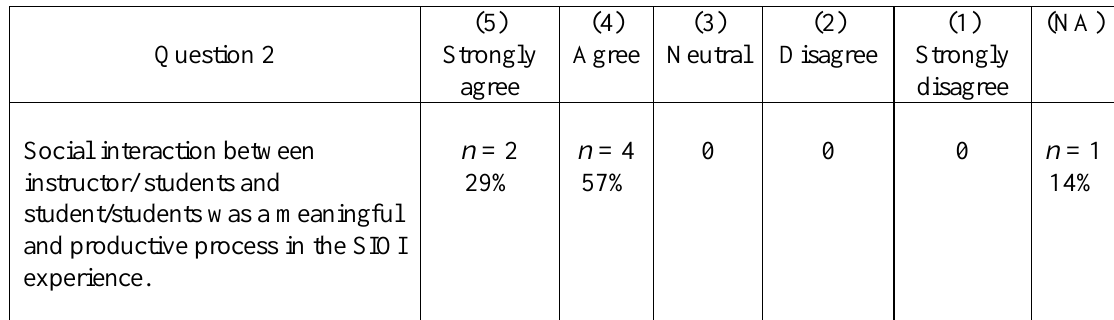
Social interaction between instructor/ students and student/students was a meaningful and productive process in the SIOI